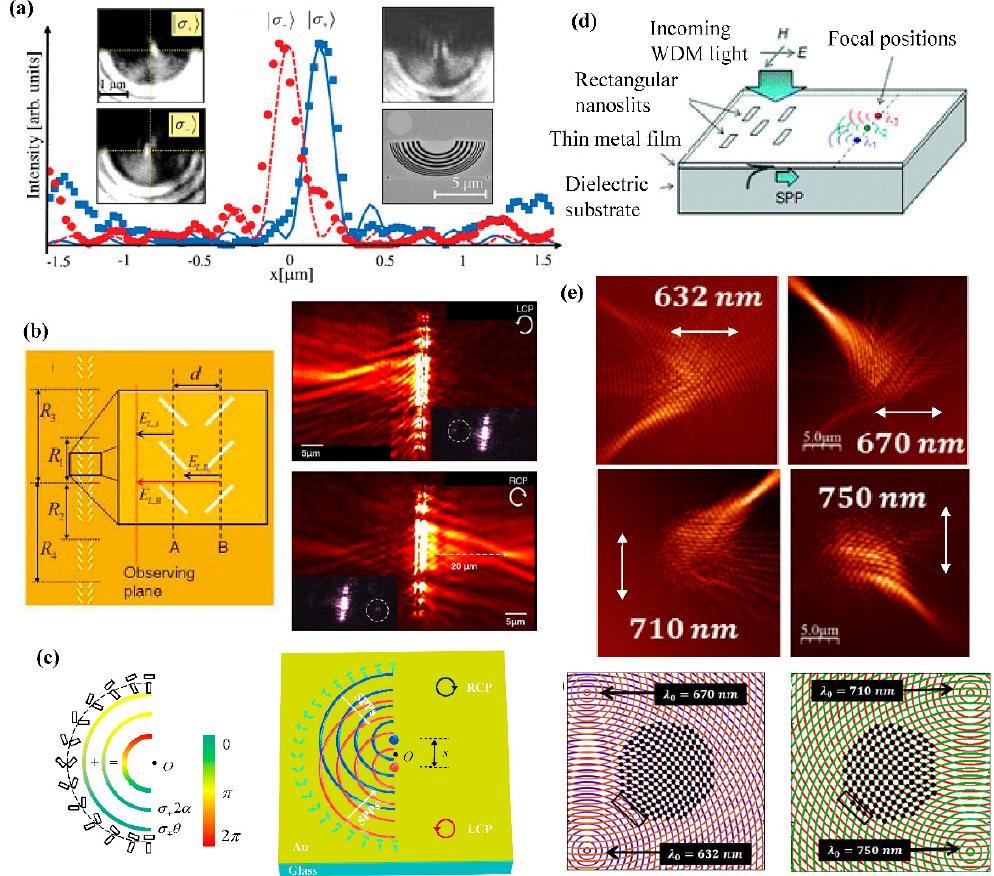
Figure 3. ( a ) Polarization-controlled focusing of SPP with semicircular slits [58]; ( b ) Spin-selected SPP focusing with vertically arranged nanoslits [46]; ( c ) Enlarging the spin-dependent transverse shift of SPP focus by introducing additional spiral phase [62]; ( d ) Multiple-wavelength focusing of SPP with a nonperiodic nanoslit coupler [81]; ( e )Switchable SPP focusing by changing either the wavelength or polarization of incident light [64]. Reproduced with permissions from: [58], APS, 2008, [46], OSA, 2015, [62], OSA, 2019, [81], ACS, 2011, [64], ACS,